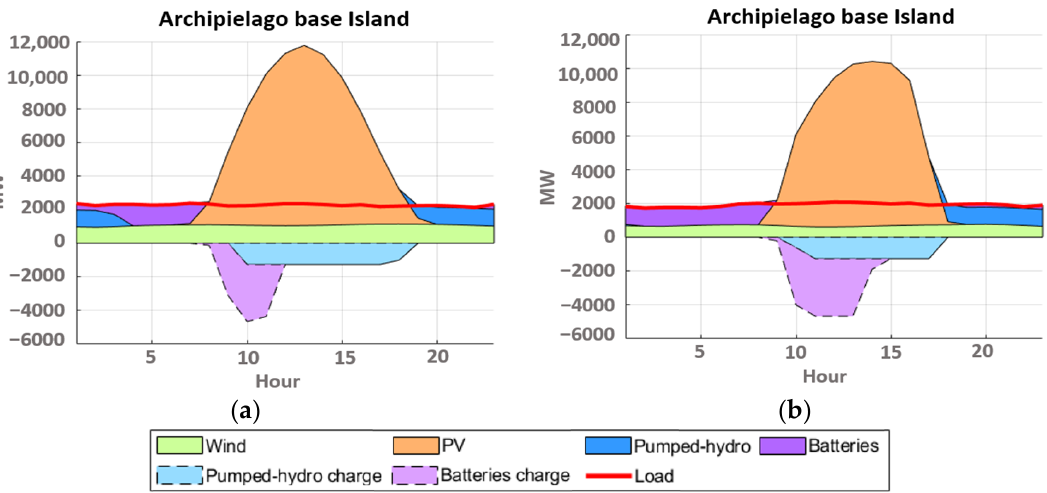
Figure 18. Hourly performance of the generation and storage systems in a typical day of ( a ) summer and ( b ) winter.